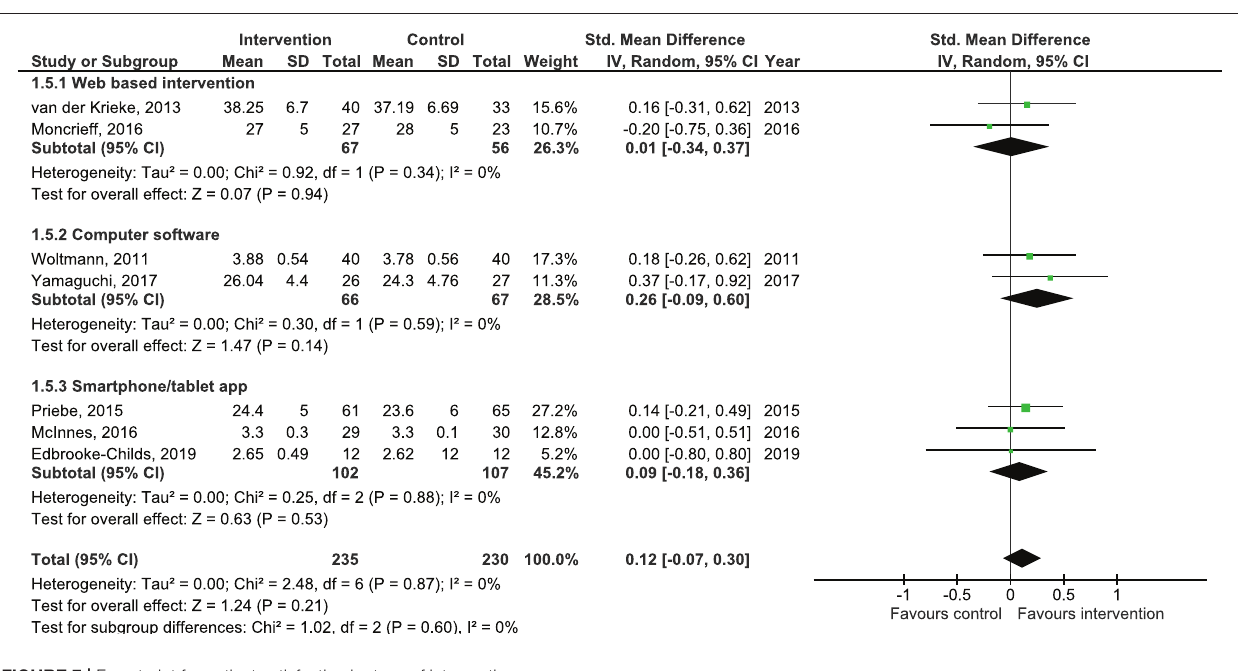
FIGURE 7 | Forest plot for patient satisfaction by type of